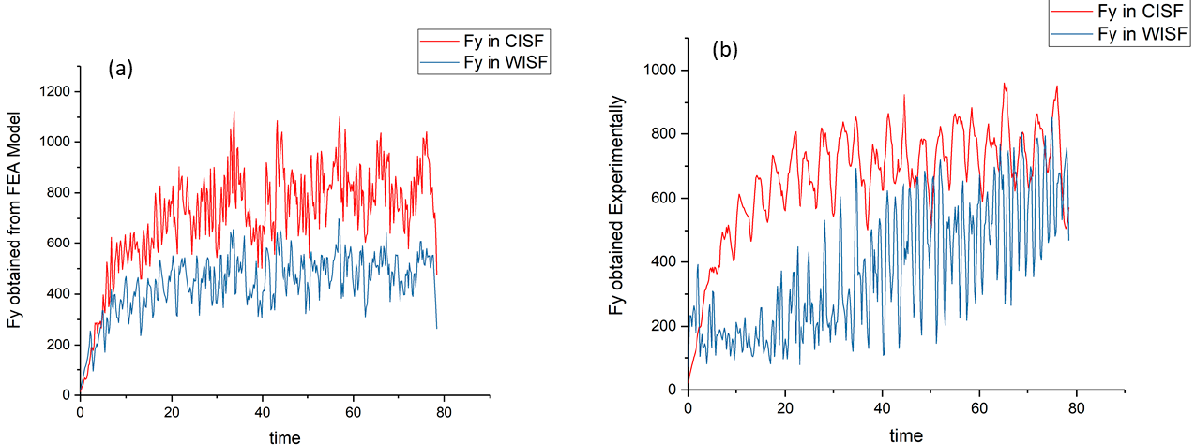
Figure 10. Comparison of Y-component of forming force: ( a ) comparison of F y in FEA modeling and ( b ) comparison of F y obtained experimentally.